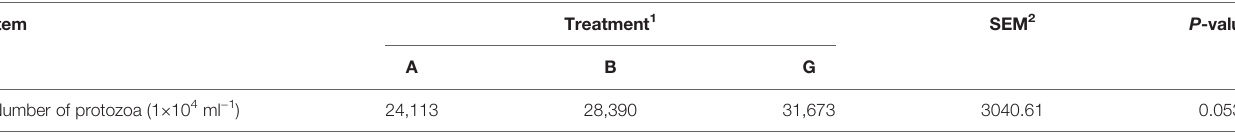
TABLE 3 | Protozoa counts affected by dietary non-protein nitrogen sources. Item